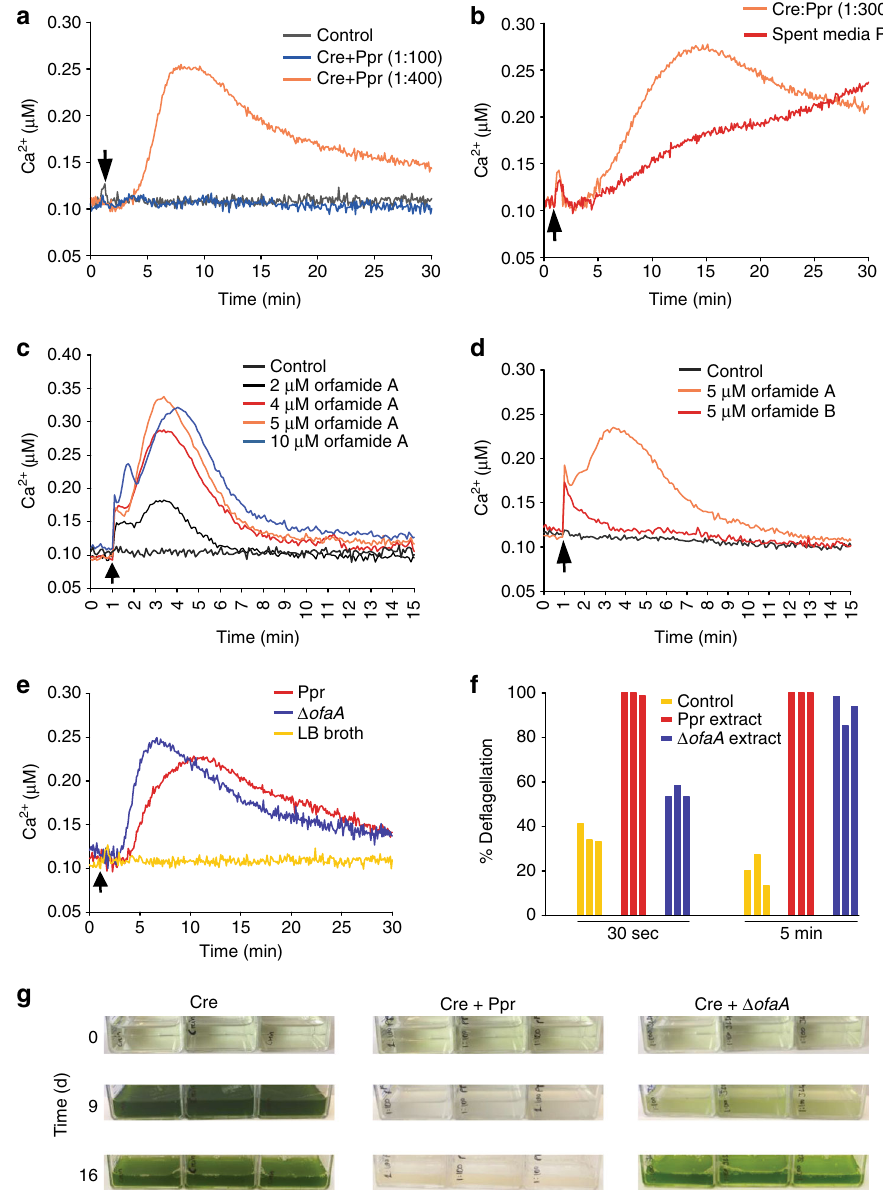
Fig. 4 Orfamides cause a rapid increase in cytosolic Ca 2+ and contribute to de fl agellation and algal growth arrest. a P . protegens is able to trigger Ca 2+ changes in C . reinhardtii . Time course of cytosolic Ca 2+ concentrations after addition of bacteria to AEQ34 cells. For the Ca 2+ measurements, the bacterial cell density was adjusted to the indicated cell ratios. As control, LB broth was added (black arrowhead). b Effect of P . protegens spent medium on cytosolic Ca 2+ levels in C . reinhardtii . Aequorin-expressing cells (AEQ34) were incubated with P . protegens in a ratio of 1:300 and used for the measurement. Further, sterile- fi ltered spent medium from an overnight culture of P . protegens (black arrowhead) was used. c Orfamide A elicits dose-dependent Ca 2+ changes. Orfamide A that was dissolved in methanol and further diluted in TAP medium was added to cells at the indicated concentrations. As control, methanol proportional to that of the highest concentration of orfamide A was used. d Ca 2+ measurement upon treatment with 5 μ M orfamide A or B. As control, methanol was used. e Ca 2+ measurements with wild-type P . protegens or Δ ofaA mutant at a ratio of 1:400 of algae to bacteria. f Extracts prepared from supernatants of P . protegens and the Δ ofaA mutant cultures, respectively, having similar cell densities (around 3.14 × 10 8 and 3.16 × 10 8 cells ml − 1 , respectively) were incubated with C . reinhardtii at a 1% concentration for 30 s or 5 min in triplicates. A 1% extract of TAP medium was taken as control. g Liquid co-cultivation of C . reinhardtii together with wild-type P . protegens or Δ ofaA mutant compared to axenic algal cultures. A 1:100 ratio of algae to bacteria was used for inoculation with an initial concentration of 10 5 algal cells per ml. The corresponding growth curves are depicted in Supplementary Fig. 12. a – e Each line in the graph represents the mean of three biological replicates, and each biological replicate includes three technical replicates. All experiments were replicated twice except for f that was performed once with one biological and three technical replicates. The experiment in g was performed twice with three biological